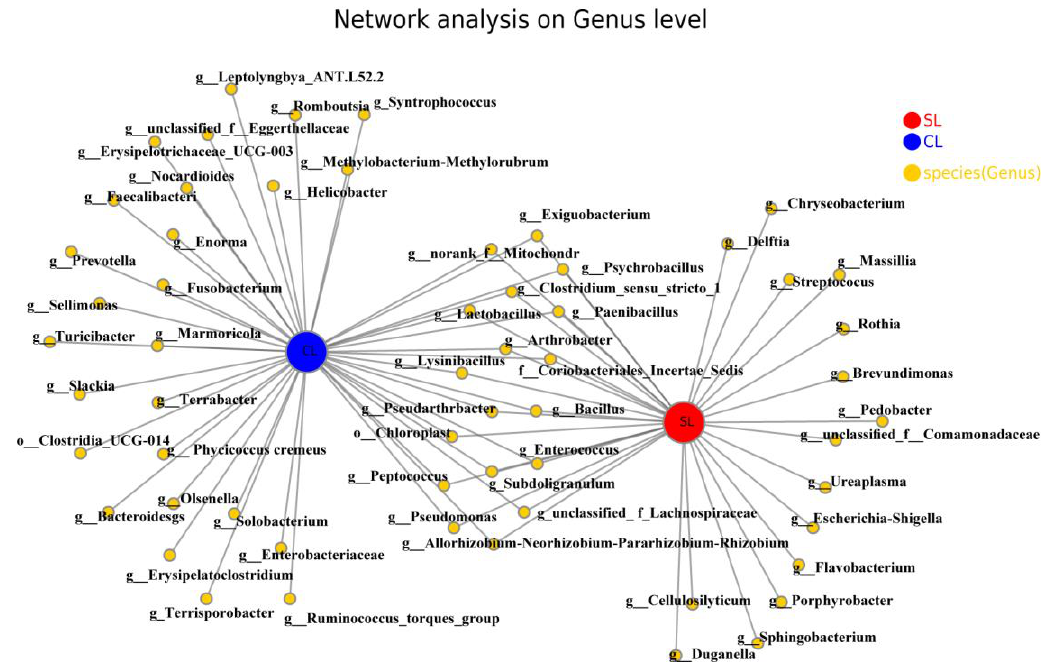
Figure 7. Network analysis of intestinal microbiota of SL and CL Anser fabalis.